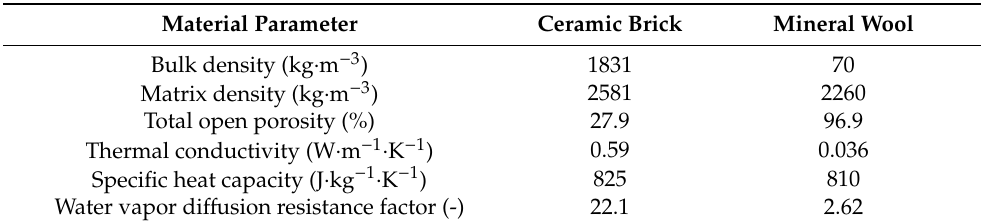
Table 2. Parameters of applied